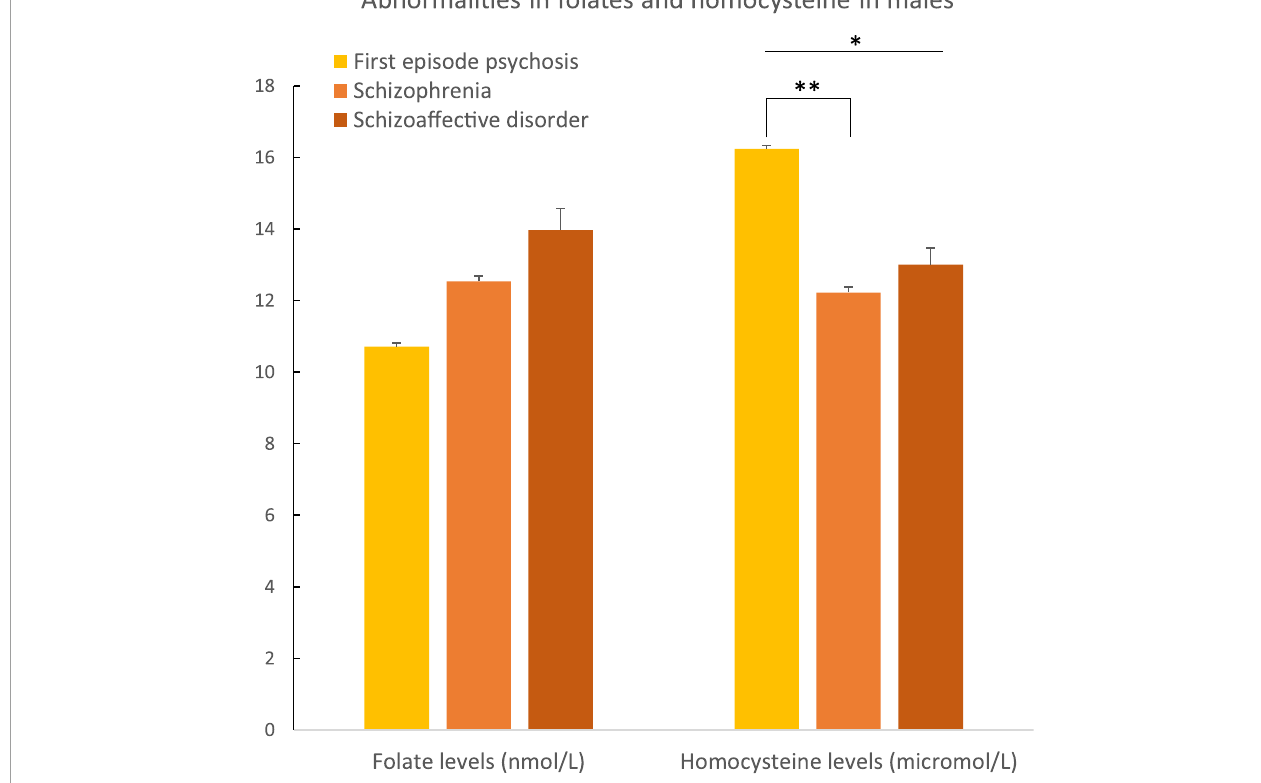
FIGURE4 Abnormalities in folate and homocysteine in males according to psychosis spectrum diagnoses. Differences in homocysteine levels were observed between the three diagnostic groups in males ( p = 0.04). Differences in homocysteine levels were observed between male patients with a first episode of psychosis and male patients with schizophrenia ( p = 0.01). * p ≤ 0.05 and ** p ≤